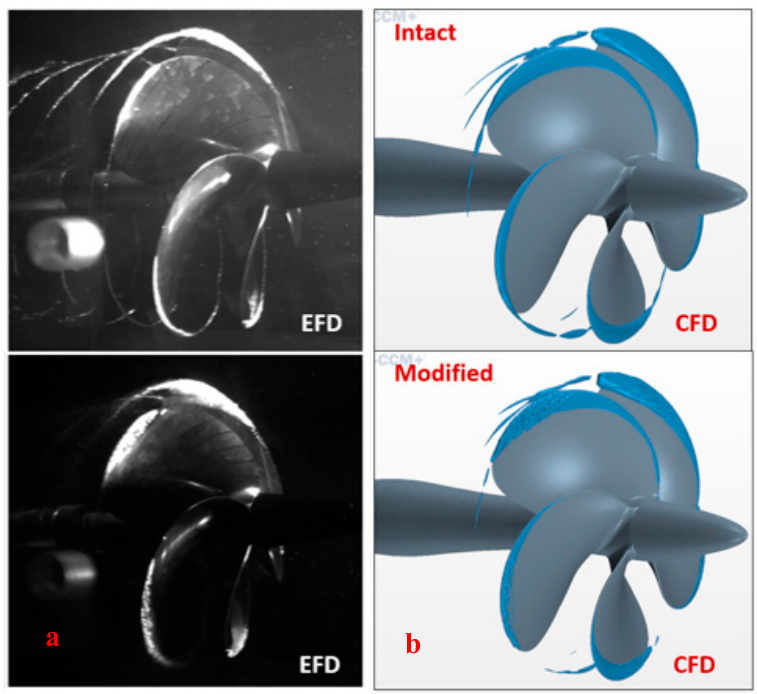
Figure 25. Comparison between ( a ) EFD ( Left ) and ( b ) CFD ( Right ) for intact and modified propellers.